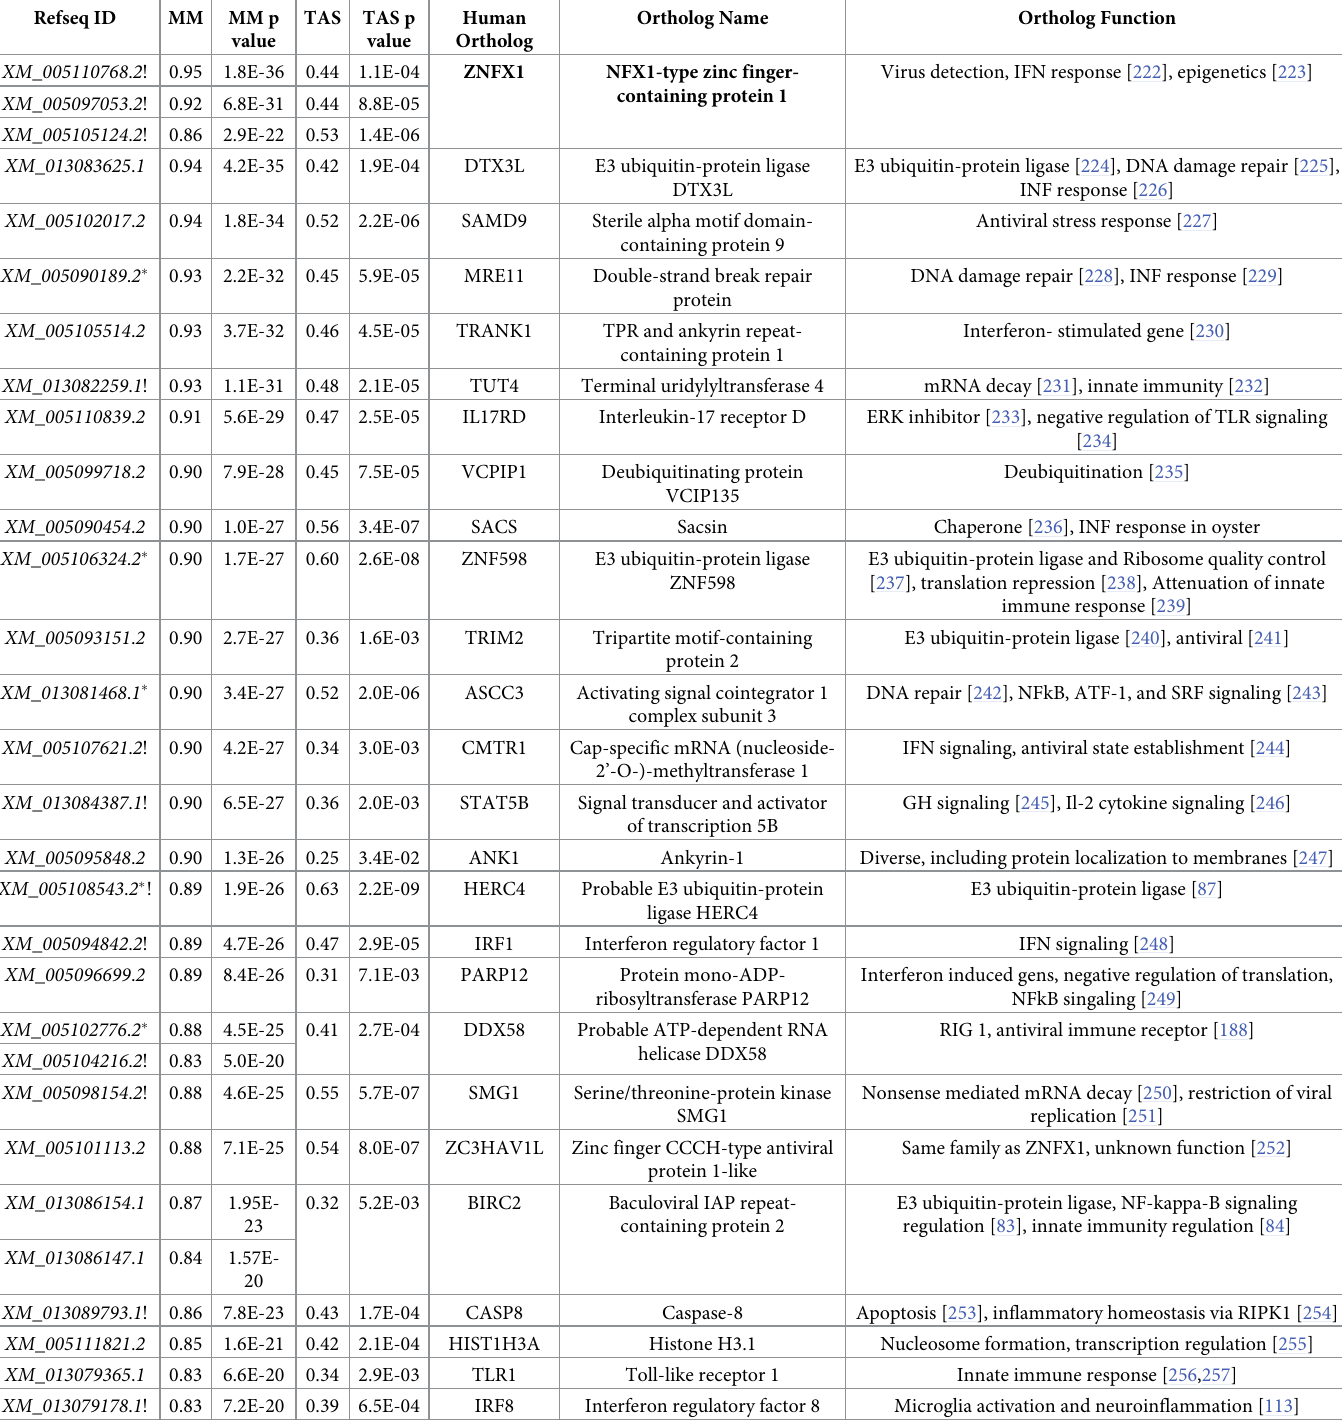
Table 6. Selection of transcripts with highest correlation to transcript co-expression module eigengene (module membership, MM) in the greenyellow consensus module identified in Aplysia californica sensory neurons by WGCNA